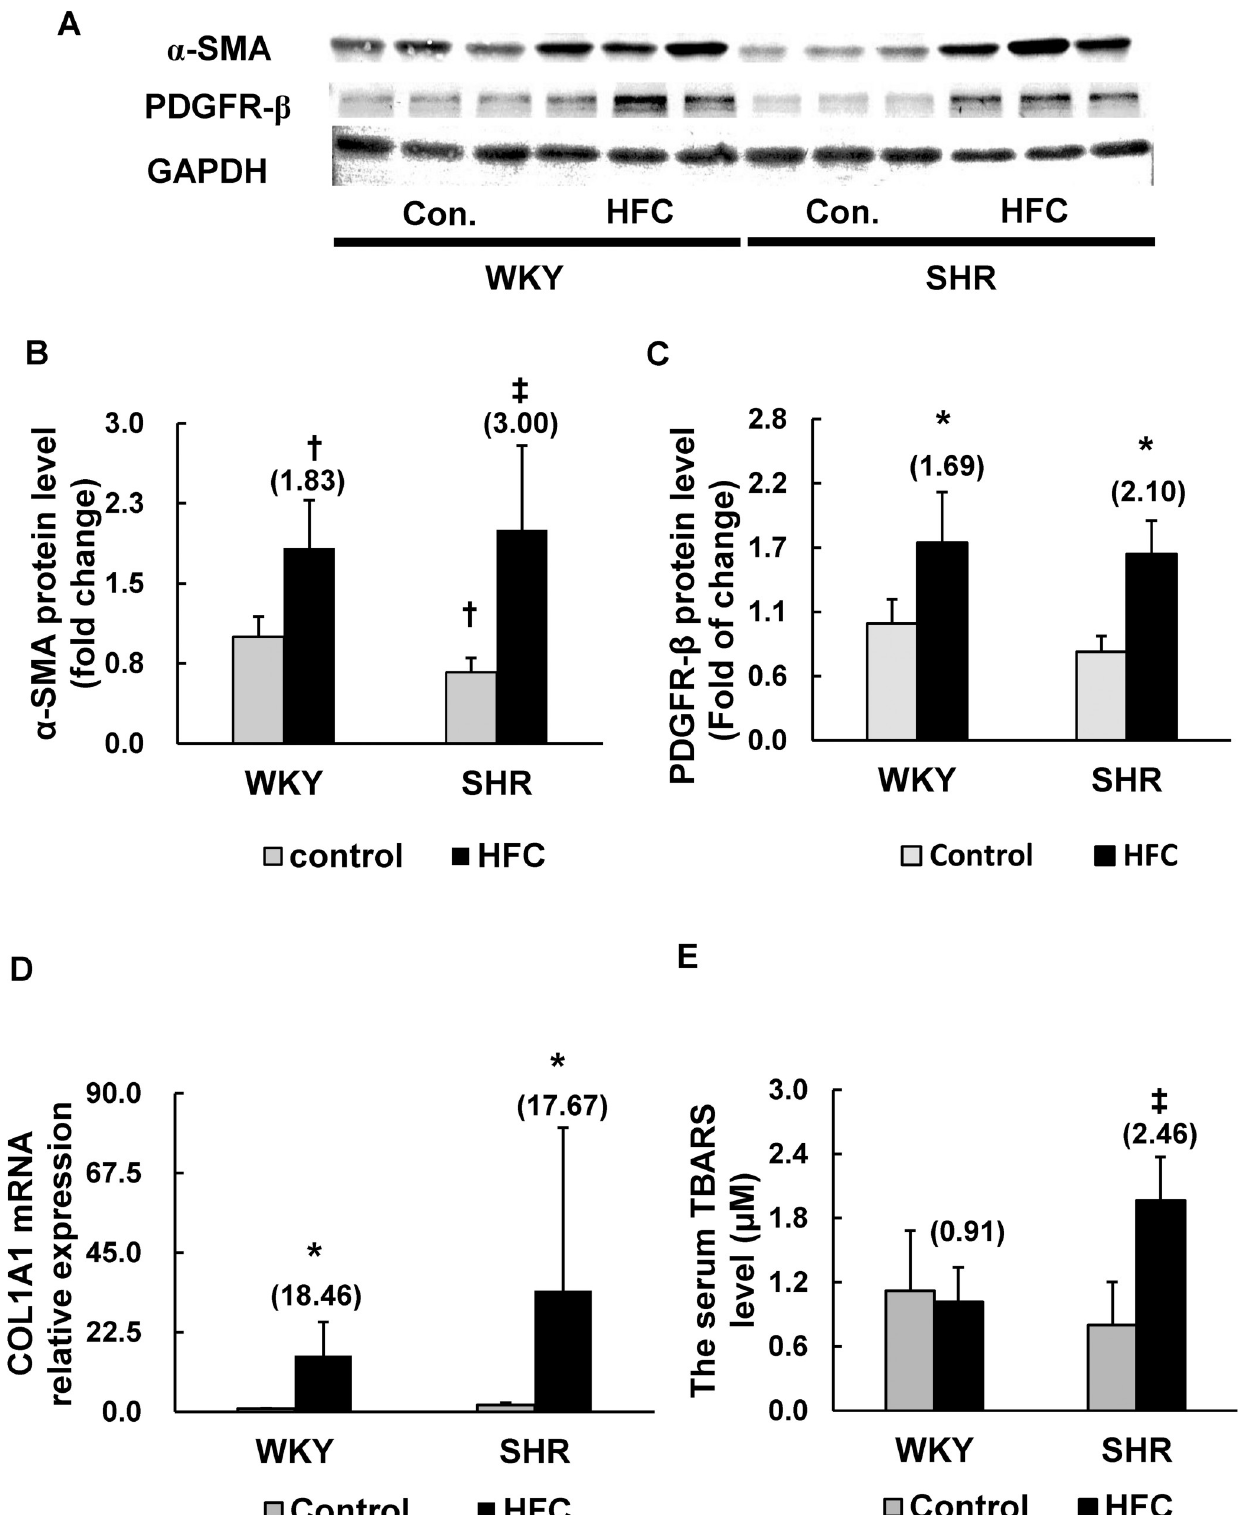
Fig 3. Effects of HFC diet on the expression of liver fibrosis-related genes. Western blots of the protein expression of α -SMA (A, B) and PDGFR- β (A, C) in the livers of WKY and SHRs fed the control or HFC diet. RT–qPCR measurements of the hepatic expression of COL1A1 mRNA (D). Serum TBARS